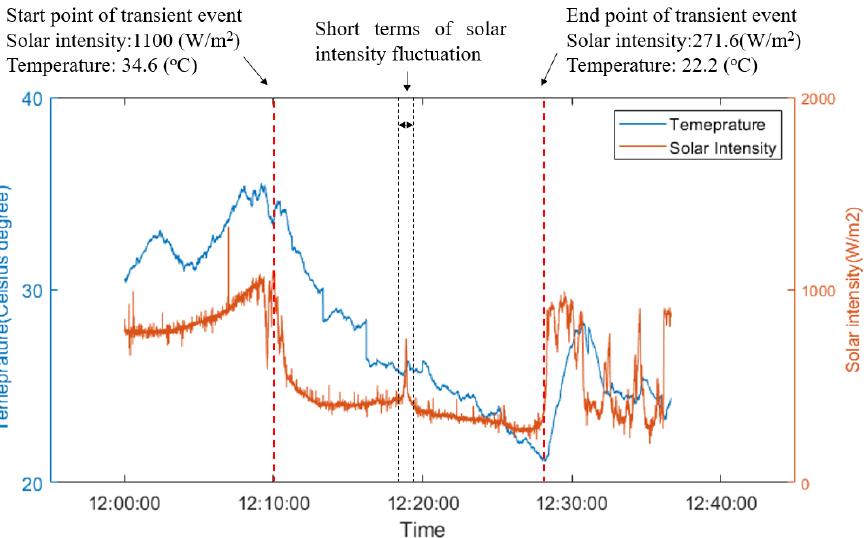
Figure 8. Temperature profile from a pixel on the air region in thermal image sequences and solar intensity history.